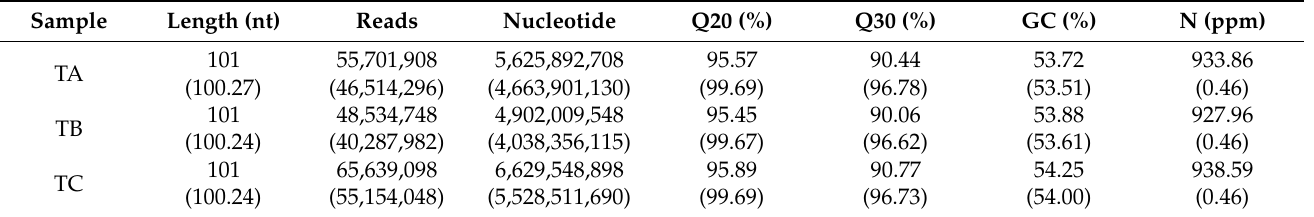
Table 3. Statistics of RNA-Seq data for three groups (i.e., TA, TB, and TC) of Mortierella alpina . The statistics for the clean data based on Trimmomatic are given in parentheses.